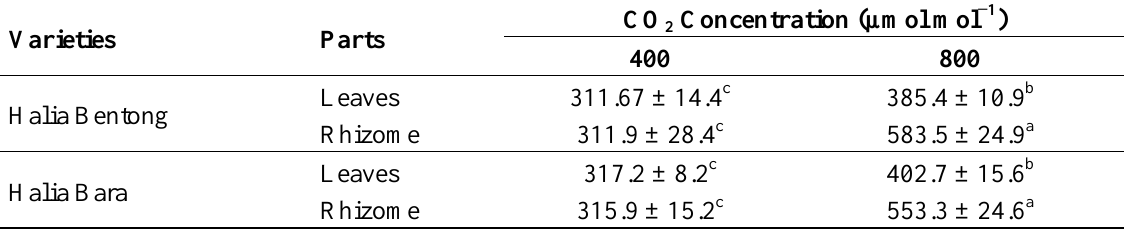
Table 4. Starch content in different parts of ginger ( Z. officinale ) varieties grown under different CO concentration. 2